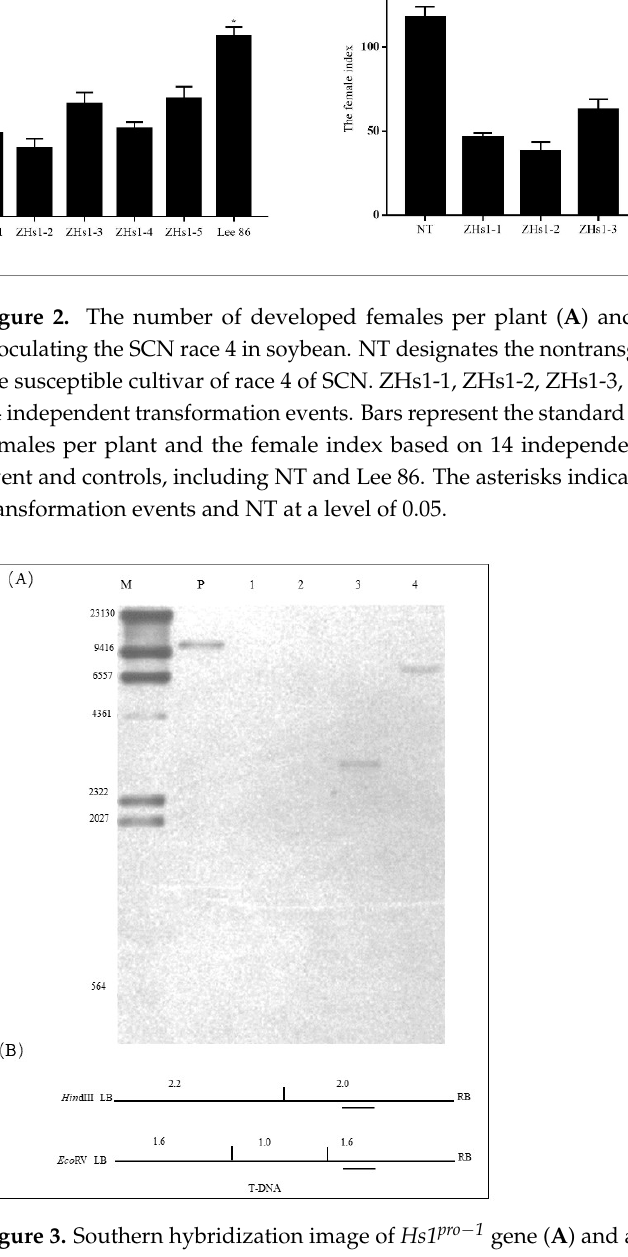
Figure 3. Southern hybridization image of Hs1 pro − 1 gene ( A ) and a schematic diagram of the re- striction enzyme digestion site and the specific probe location of T-DNA ( B ). In (A): M, DNA Marker (bp), DIG-labeled (Roche); P, positive control, Hs1 pro − 1 gene plasmid DNA; 1, the NT ‘ Tianlong 1 ’ ge- nomic DNA digested with Hind III restriction enzyme; 2, NT ‘ Tianlong 1 ’ genomic DNA digested with EcoR V restriction enzyme; 3, T5 ZHs1-2 transformation event genomic DNA digested by the Hind III restriction enzyme; 4, T5 ZHs1-2 transformation event genomic DNA digested with EcoR V restriction enzyme. In ( B ), the vertical lines indicate the location of the restriction enzyme site digestion and the digested band size (bp); the short dashes indicate the location of the hybridization